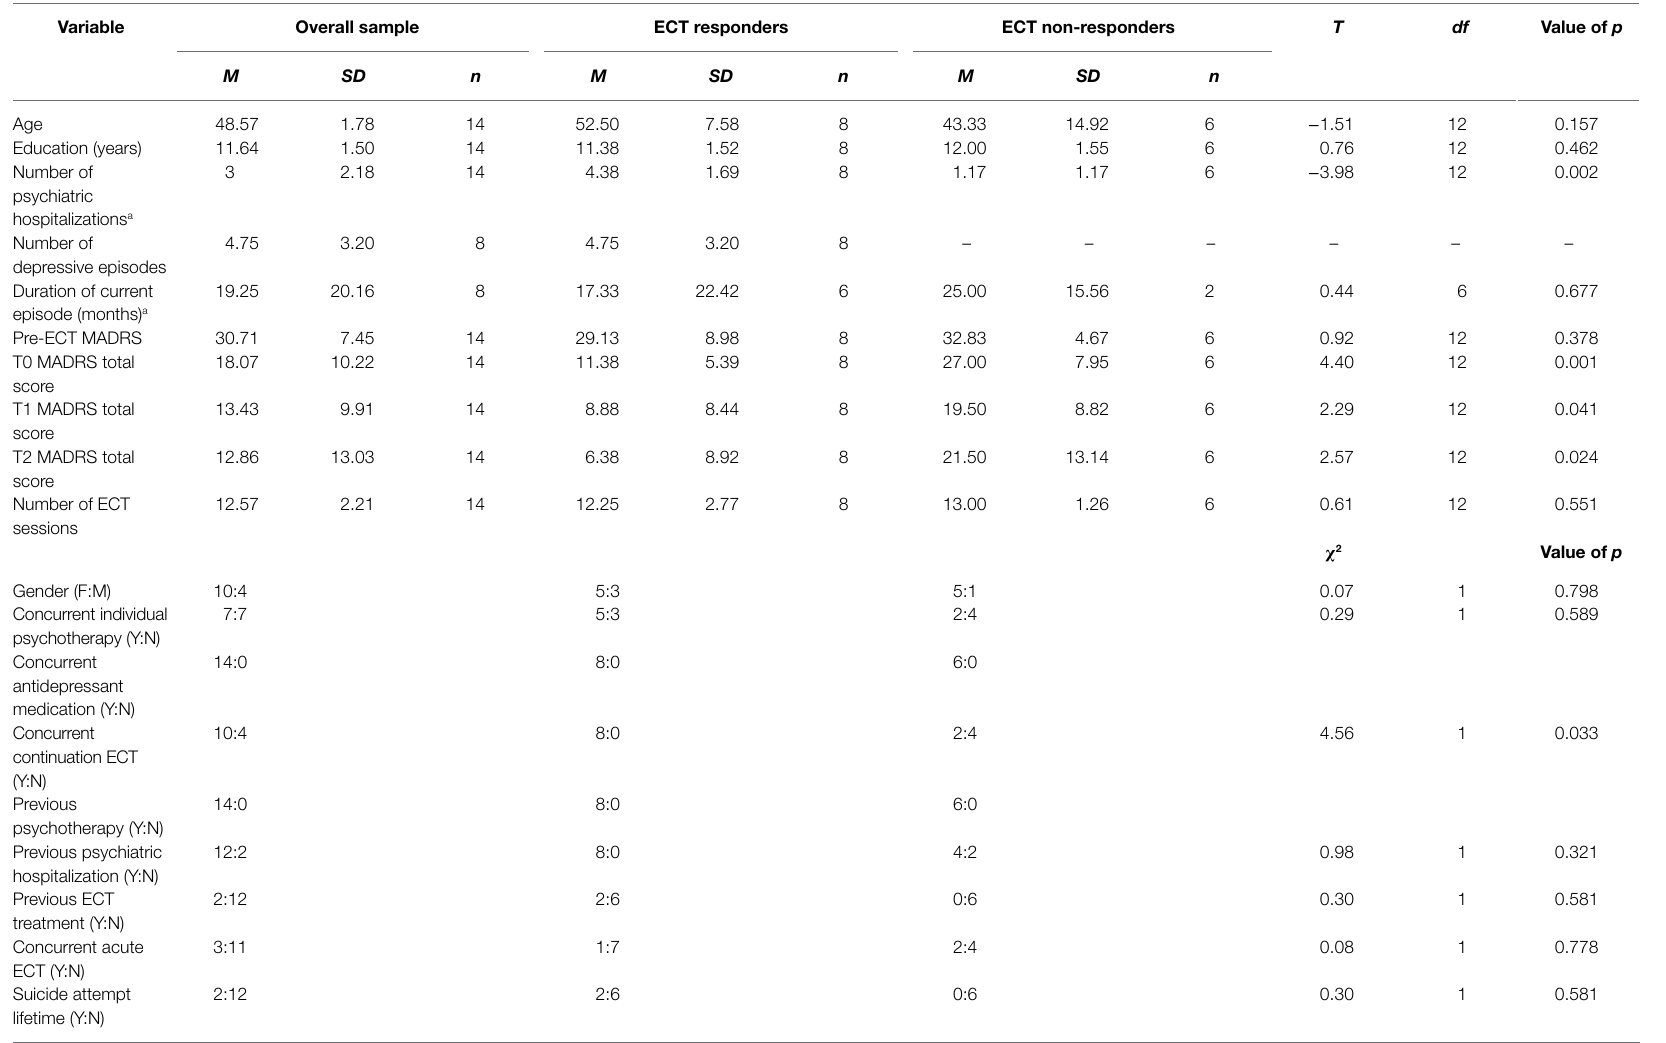
TABLE 1 | Demographic and clinical